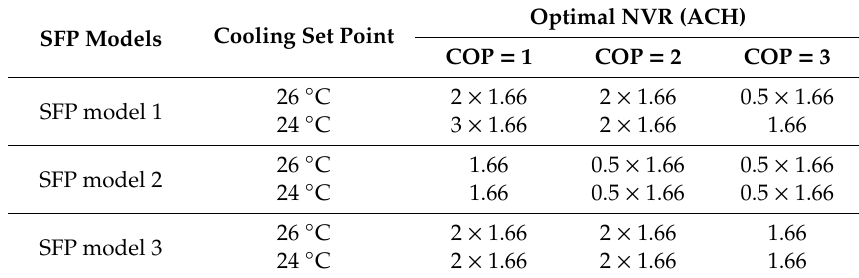
Table 12. The NV rates (ACH) at which the minimum total electricity use for cooling during the hot summer of 2018 occurs for di ff erent COP values for operative temperature cooling set points of 26 and 24 ◦ C.